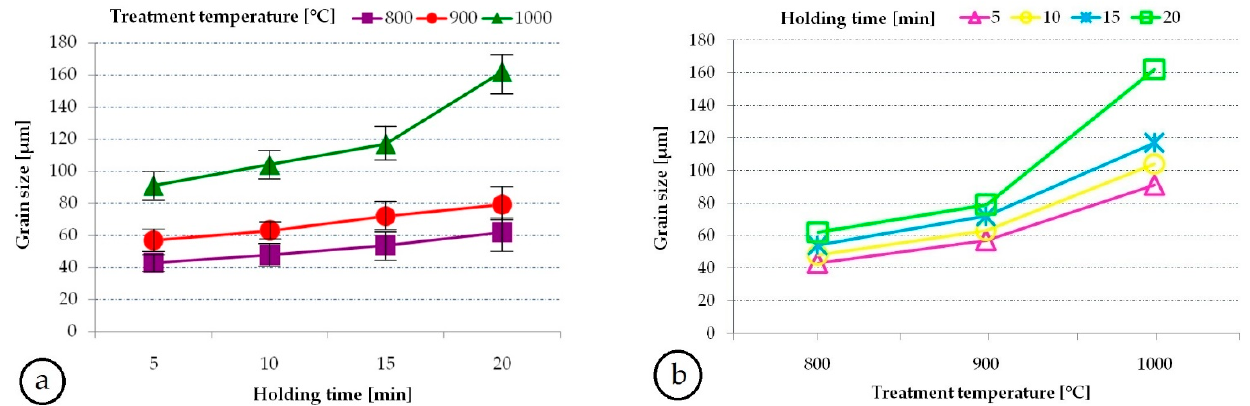
Figure 10. The evolution of grain-size distribution in a TNTZ alloy during ST treatment, as a function